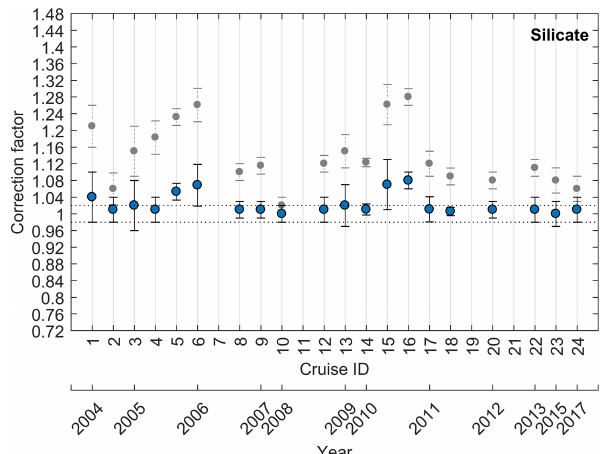
Figure 7. The same as Fig. 5 but for